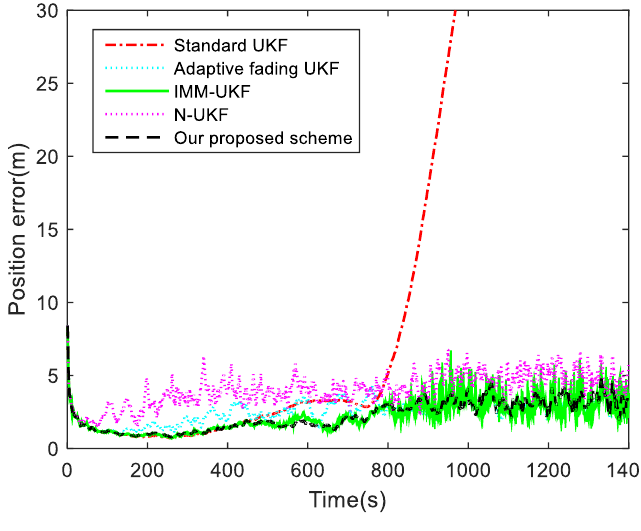
Figure 3. Position tracking errors for Case 1. Table 1. Position errors of the different schemes for Case 1.